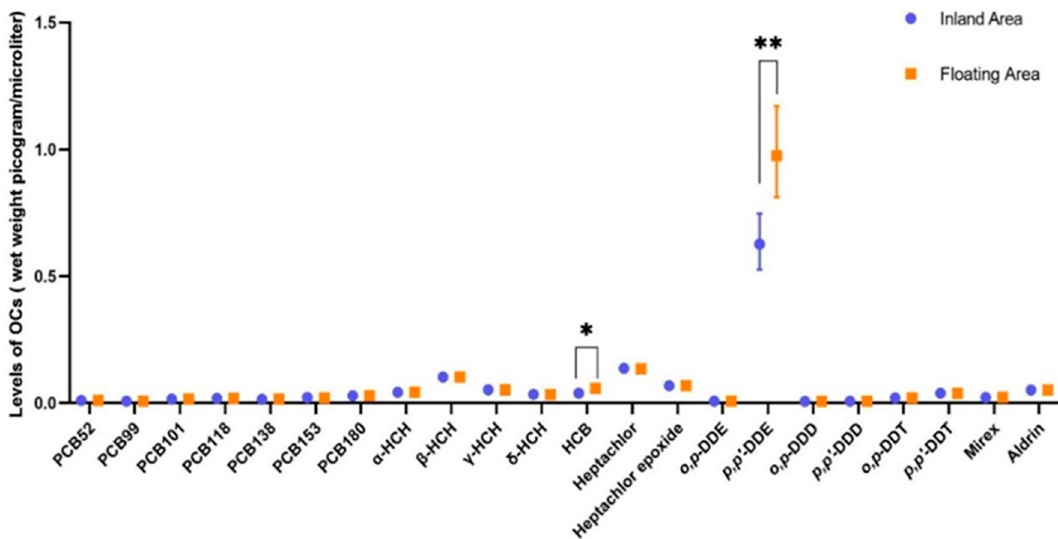
Figure 1. Geometric means of the organochlorine compounds concentration in mothers living in inland and floating area (wet weight picogram/microliter). The vertical bars plot the 95% confidence intervals. * p = 0.002; ** p < 0.001, there are significant differences of maternal blood hexachlorobenzene (HCB) and p,p’-DDE levels between inland and floating areas in Mann–Whitney U test.